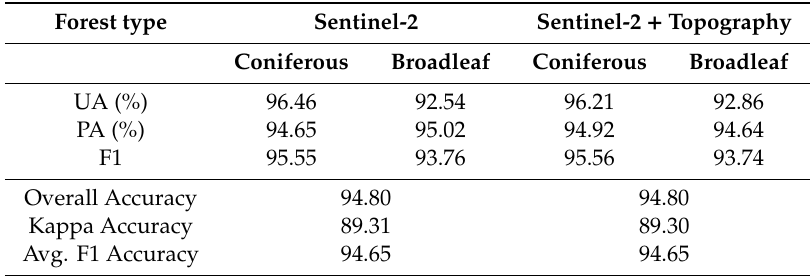
Table 3. The accuracy of the classification of coniferous and broadleaf